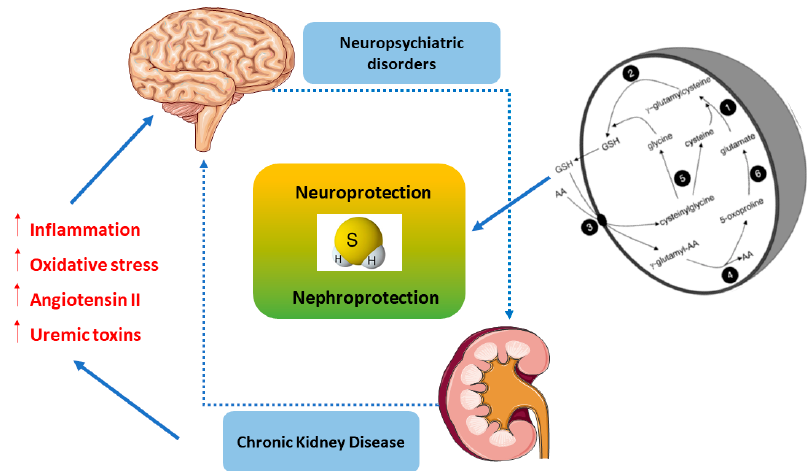
Figure 2. The kidney–brain crosstalk by the H 2 S signaling pathway. γ -glutamyl transpeptidase ( γ GGT) (3), γ -glutamyl cyclotransferase (4), dipeptidase (5), oxoprolinase (6), γ -glutamyl-cysteine synthase (1), and glutathione synthetase (2) operate in the Meister cycle to generate glutathione (GSH) and internalize amino acids (AA).